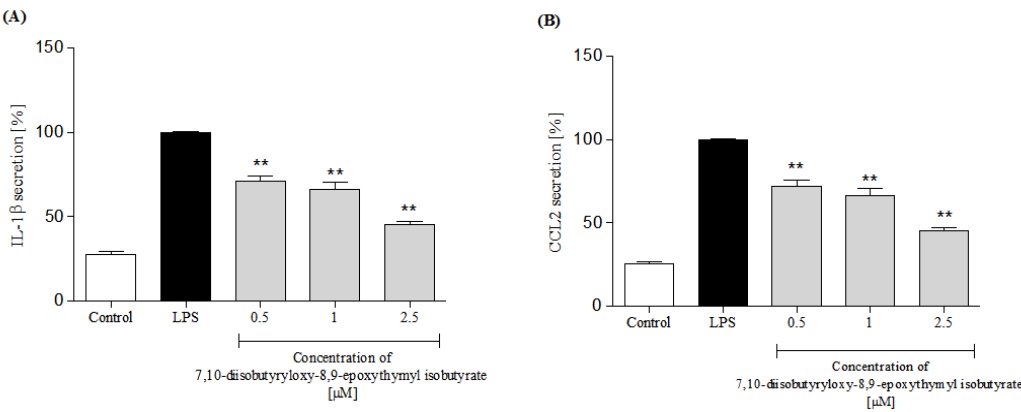
Figure 7. Inhibitory effects of 7,10-diisobutyryloxy-8,9-epoxythymyl isobutyrate, at